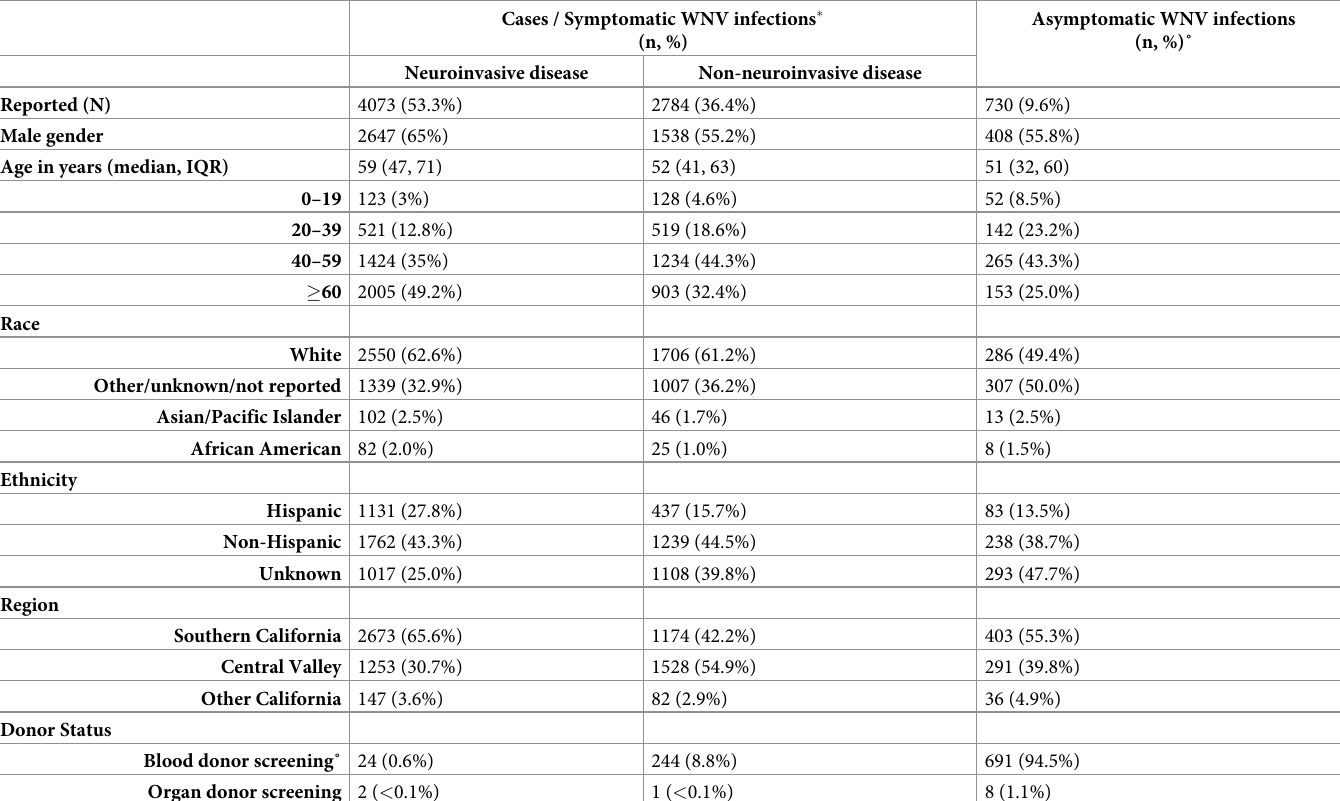
Table 1. Demographic characteristics of human West Nile virus (WNV) disease cases (n = 6,909) and asymptomatic infections (n = 730) reported to the California Department of Public Health,